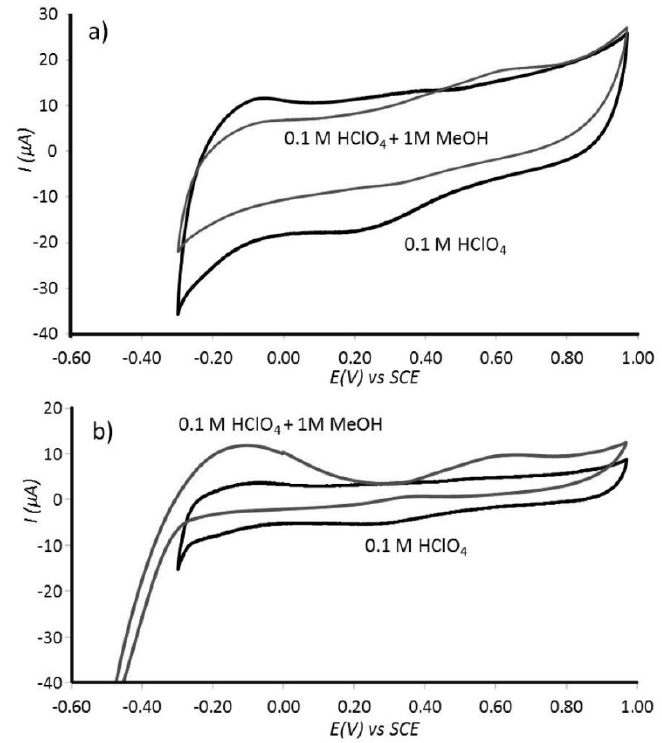
Figure 6. Cyclic voltammograms (3rd cycle) at Pt@cPIM immobilized onto a 3 mm diameter glassy carbon electrode immersed into Ar saturated 0.1 M HClO 4 without/with 1.0 M methanol recorded at a scan rate of ( a ) 100 mV s −1 and ( b ) 10 mV s −1 .